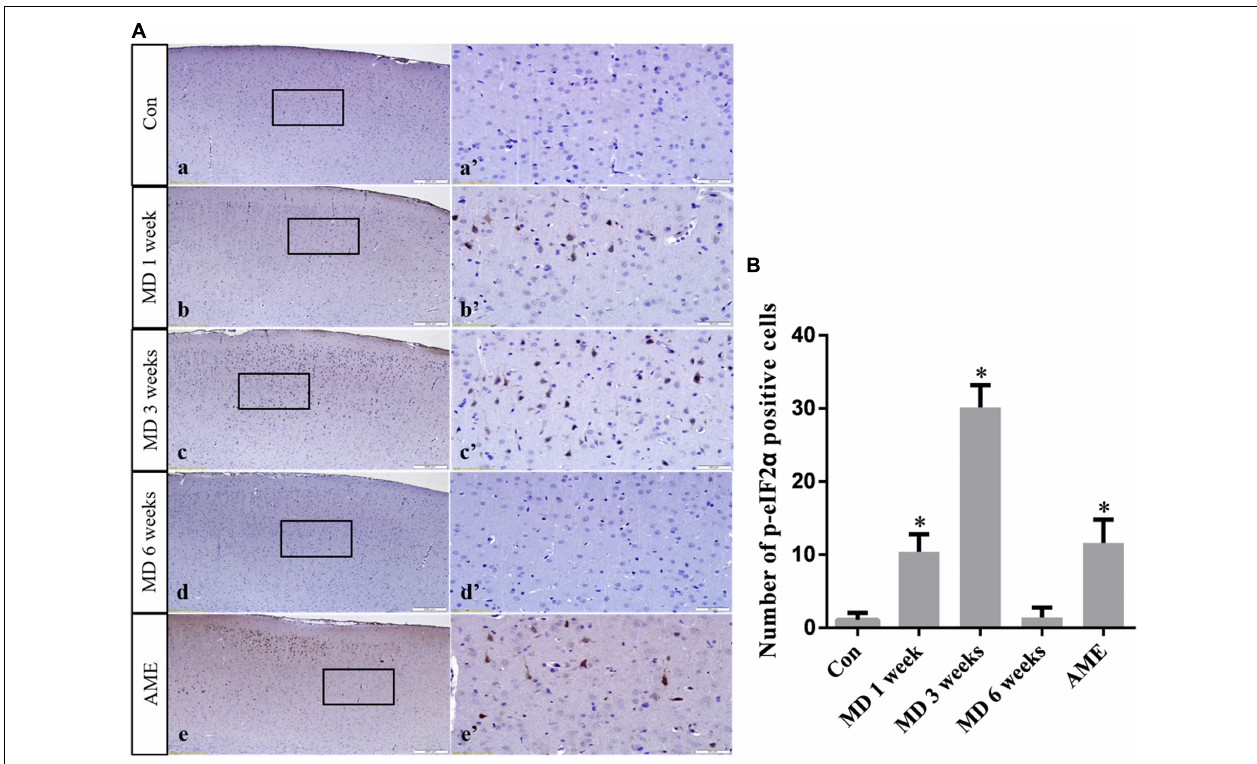
FIGURE 5 | (A) Representative images showing p-eIF2 α immunohistochemistry in the cortex. Panels (a’–e’) are magnified areas of panels (a–e) . Bars = 200 µ m in panels (a–e) . Bars = 50 µ m in panels (a’–e’) . (B) Quantitative analysis of the number of p-eIF2 α positive cells. The data are shown as mean ± SD, ∗ P < 0.05 vs. control group ( n = 6). MD, morphine dependence; AME, acute morphine